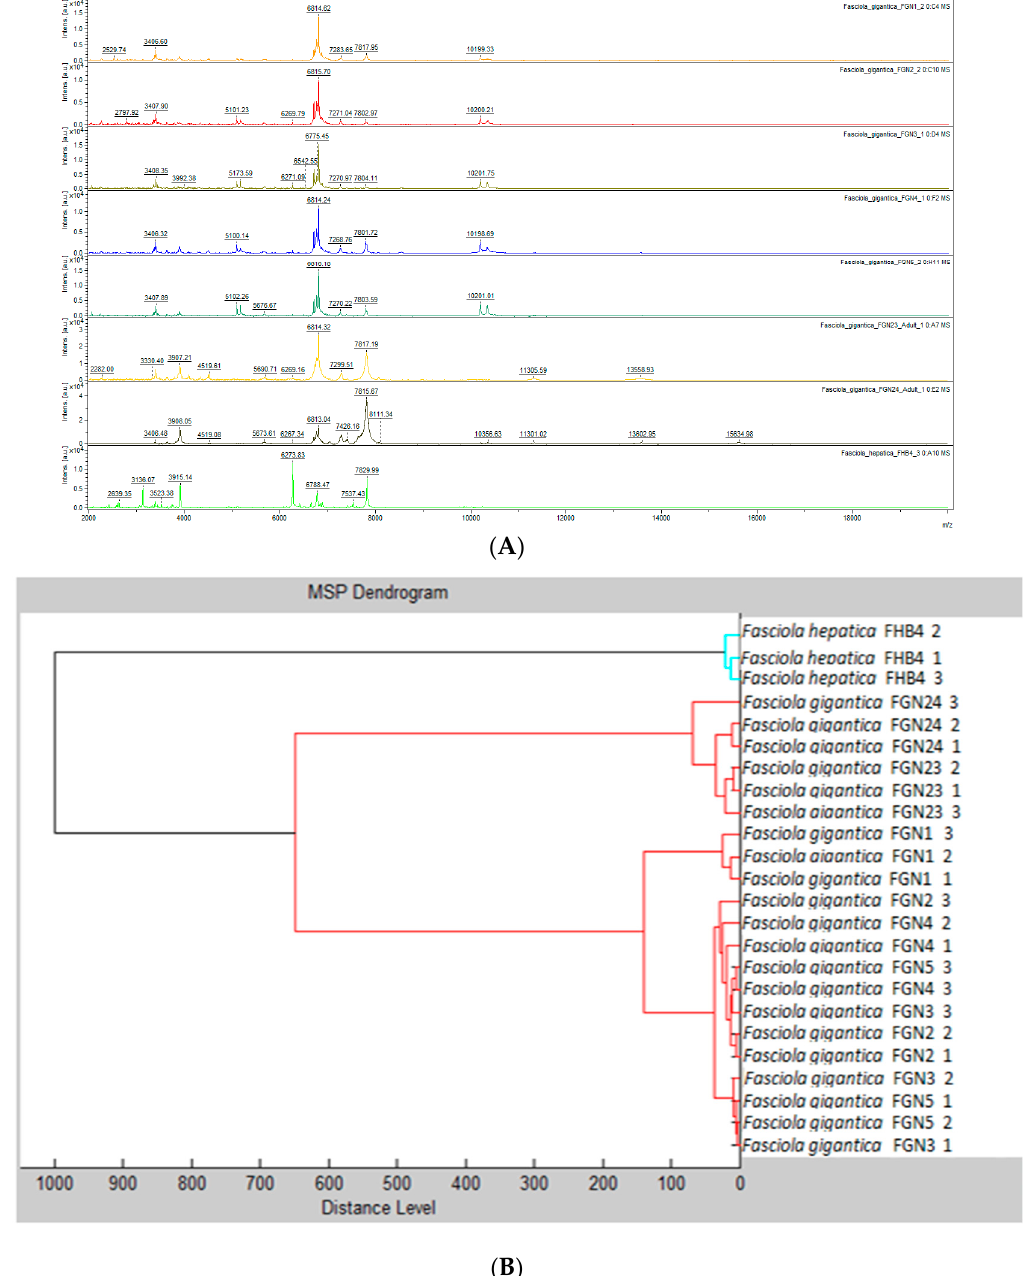
Figure 2. ( A ) Spectra obtained by matrix-assisted laser/desorption ionization time-of-flight (MALDI-TOF) mass spectrometry (MS) for seven adult Fasciola gigantica (FG) specimens and one adult Fasciola hepatica (FH) specimen. The peak intensities of ionised molecules are shown on the y-axis and the corresponding mass on the x-axis. Numbers indicate the resulting mass-to-charge-ratios. ( B ) Dendrogram analysis displaying the relatedness of the different samples. Of note, each specimen was measured thrice to assure reproducibility.